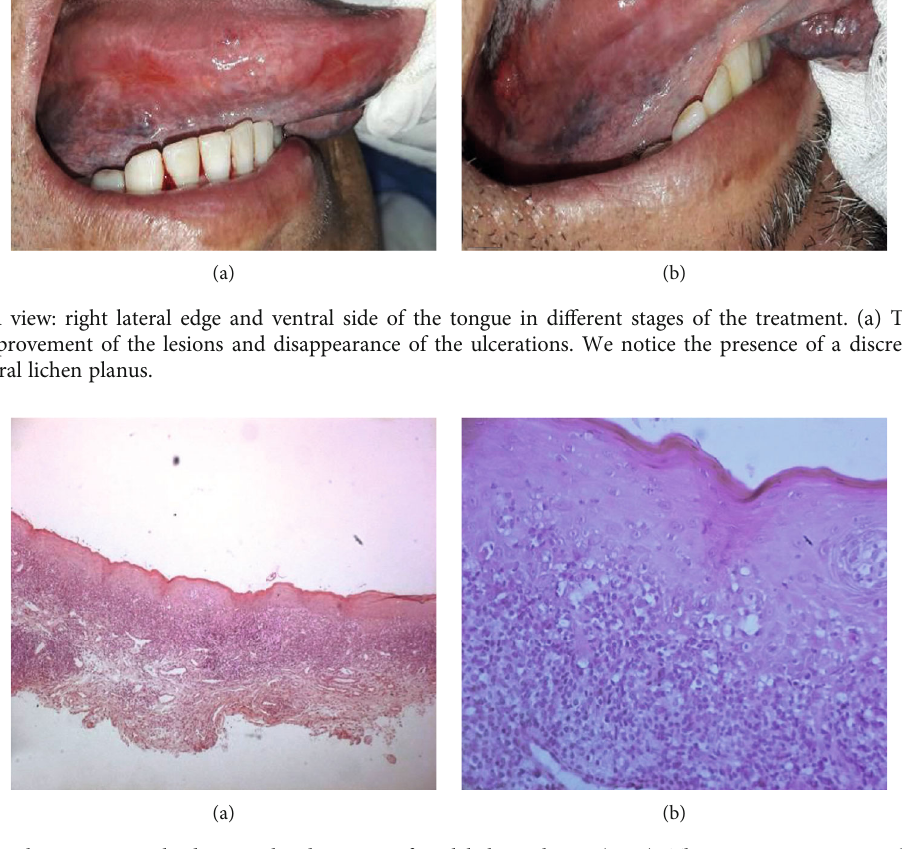
Figure 5: Histological examination leading to the diagnosis of oral lichen planus (OLP). The mucosa was covered with a squamous epithelium taking on a fl attened appearance with slight acanthosis and hyperkeratosis (essentially orthokeratosis and some focal parakeratosis). The basement membrane was vacuolated with the presence of Civatte apoptotic bodies (b). The underlying tissue is the seat of a dense linear in fi ltrate surrounding the nerve nets in places; it is mainly made of lymphocytes with rare cells of a histiocytic nature. This lymphocytic band in fi ltrate (a) at the level of the chorion attacks and gradually destroys the keratinocytes of the basal and deep seat of the epithelium. No signs of malignancy were noted. Table 1: Evolution of biological variables before and after